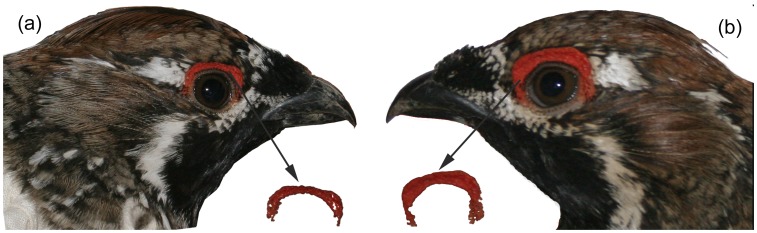
Comparing the supra-orbital comb between mated and unmated male Chinese grouse (a, unmated male grouse; b, mated male grouse).